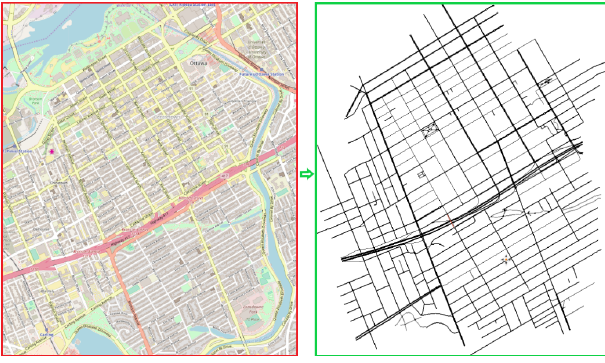
Figure 8. Topology of the Ottawa